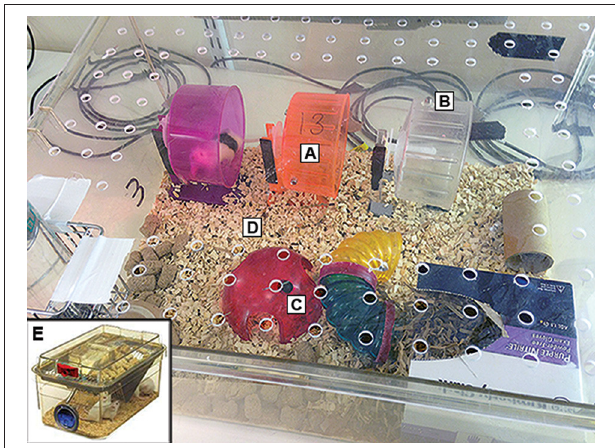
FIGURE 2 | Enriched cage . Image of our enriched cage setting. For enriched animals we used a Perspex cage that was bigger than standard dimensions (48 × 38 × 21 cm) to facilitate activity and filled with (A) plastic and colored running wheels with (B) automatic rotation counters, (C) plastic tunnels and “igloos” as well as (D) soiled bedding from C57BL6 male mice. In order to avoid the stress of handling, animals were transferred using the “tunnel handling method” and animals were monitored during the dark phase with video cameras above the cage. The C condition (E) consisted of minimal housing in accordance with the UK 3Rs guidelines (nesting material, a wooden bite block and a cardboard tube), without any extra enrichment and with a standard size cage (39 × 20 × 16 cm) and minimal disturbance (bedding change every 3–4 days; mice transferred by being picked up by the